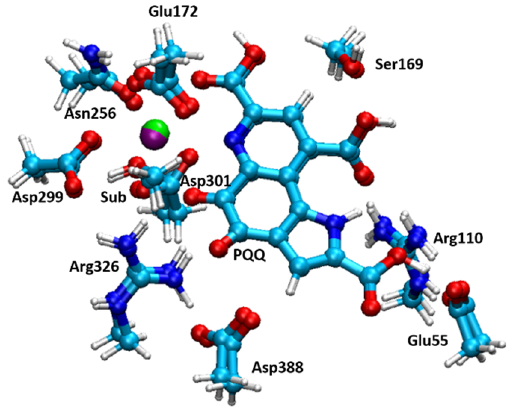
Figure 3. Superposition of B3LYP-D3/6-31+G(d,p)|SDD optimized geometries of ES complexes for the Ce 3+ -(green) and Eu 3+ -MDH (purple).